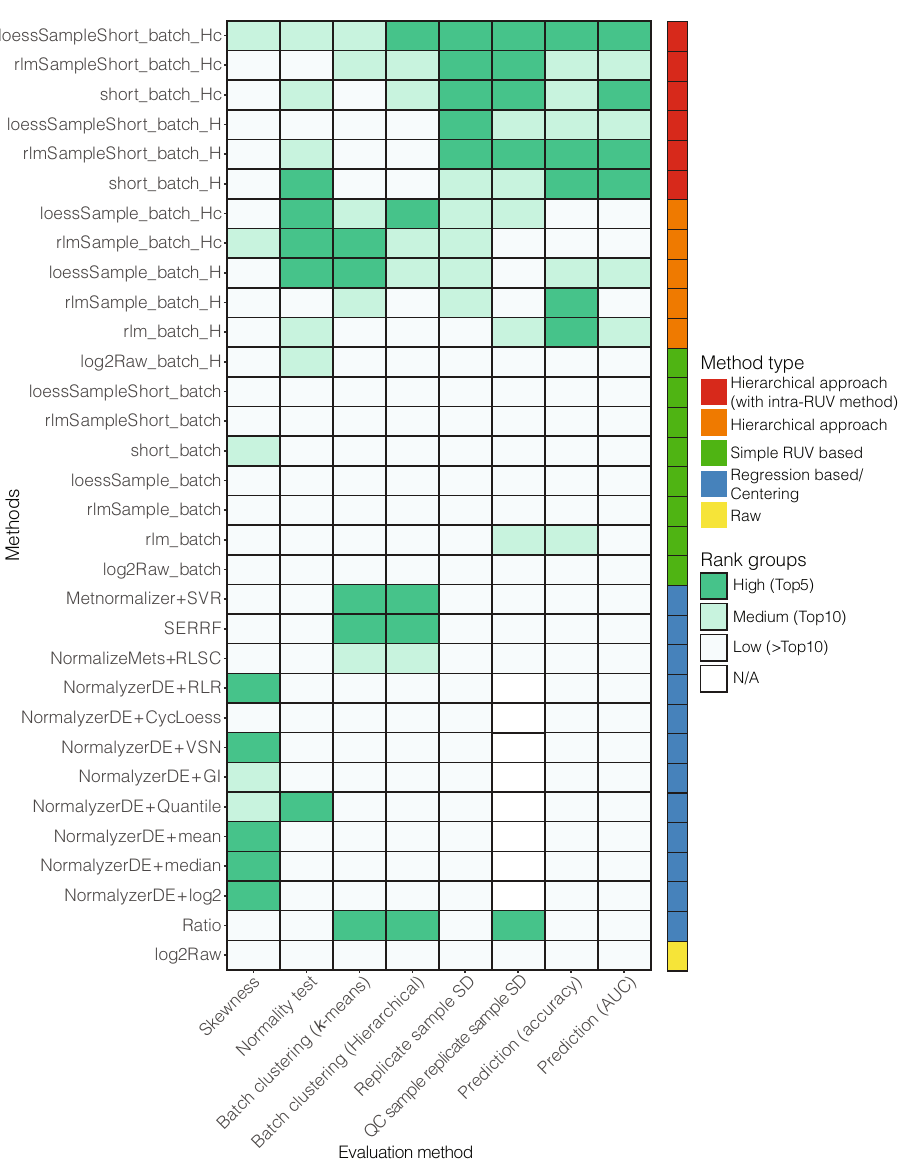
Fig. 4 Heatmap of rankings in all evaluations criteria. The y axis represents all the methods explored in this study and the x axis represents all the qualitative evaluation metrics used for the evaluation of the integrated data. In each category, the evaluation scores are ranked and categorised into three groups, high, medium and low. The coloured bar on the right indicates the categorised method approaches consistent with Fig. 3b,